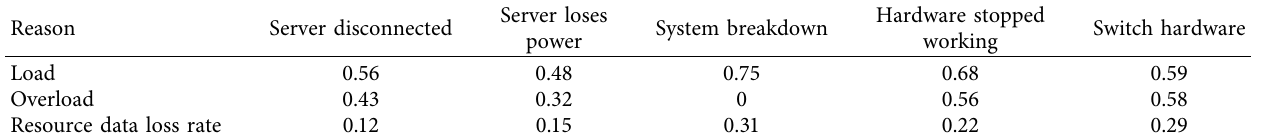
Table 3: Reliability test data.